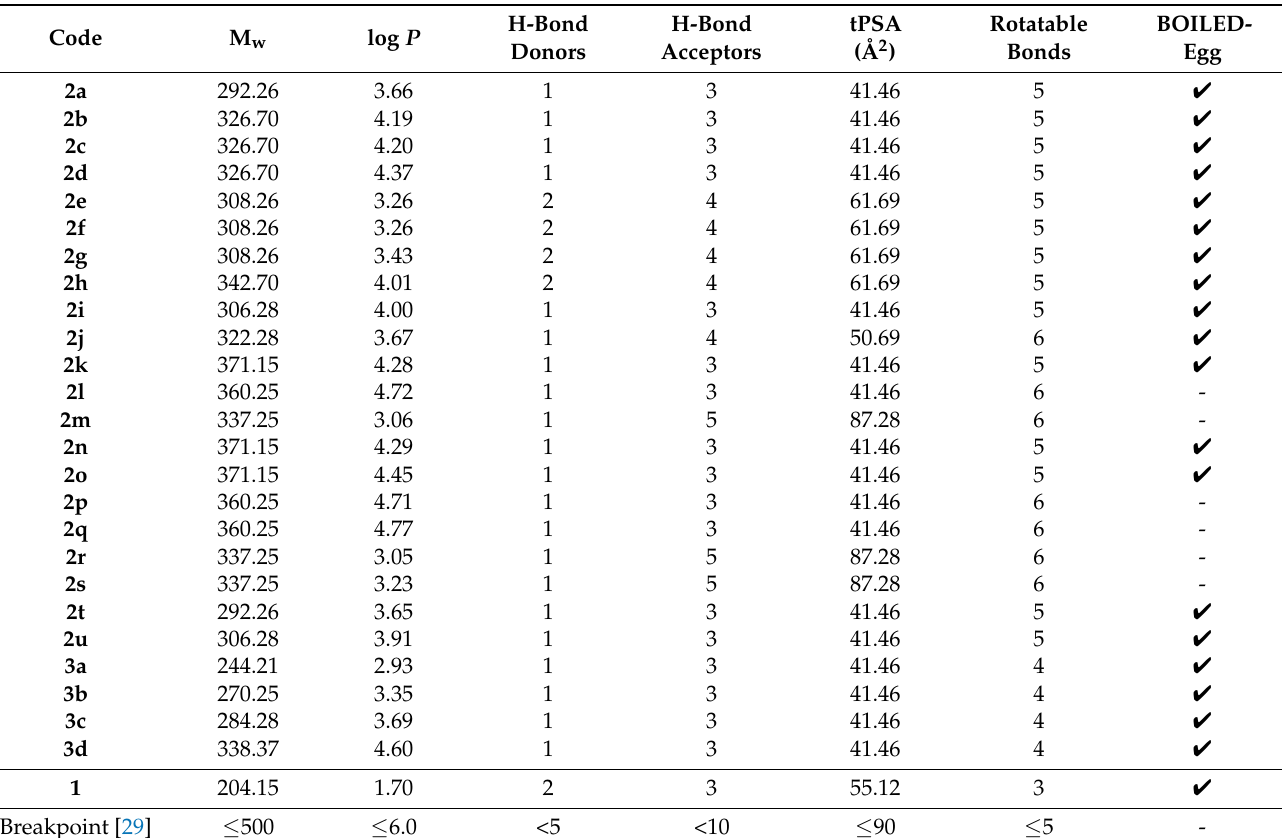
Table 2. Blood-brain barrier (BBB) permeability